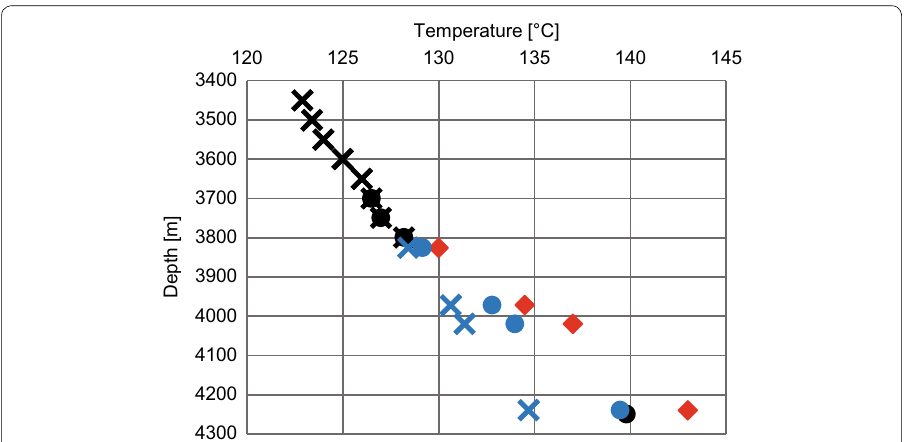
Fig. 12 Comparison of temperature extrapolation and interpolation for one well. Red diamonds: production test temperatures; blue symbols: interpolated (dots) and extrapolated (crosses) production test temperatures; black symbols: log temperatures used for interpolation (dots) and extrapolation (crosses). Some log data were used both for interpolation and extrapolation so that the symbols overlap. No correction is